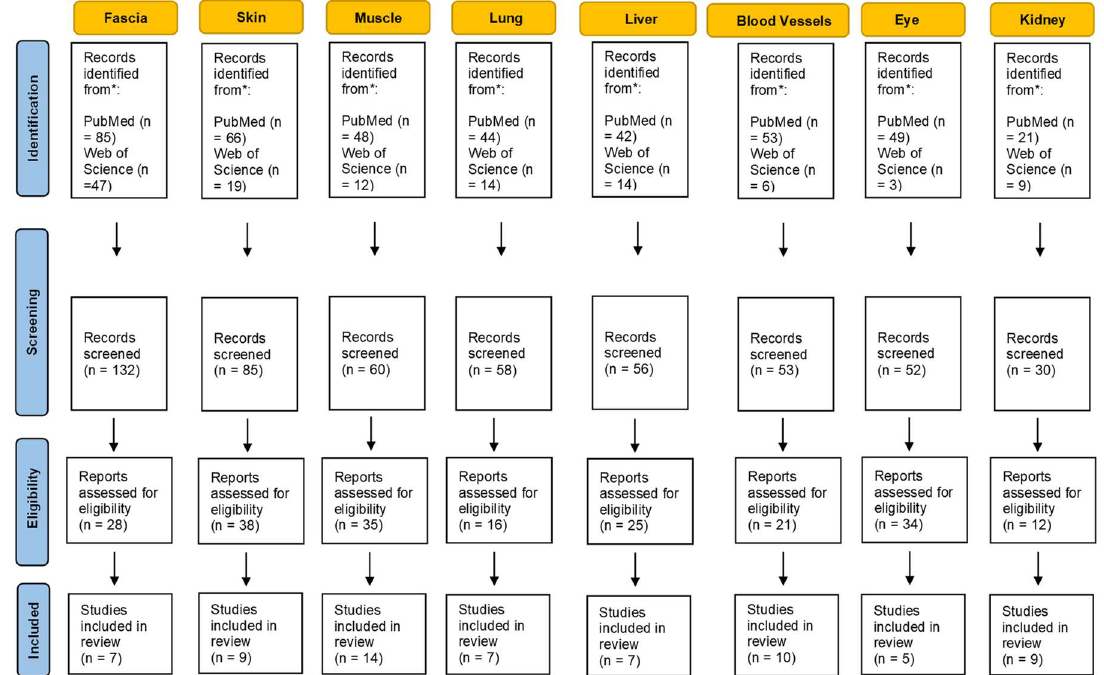
Figure 1. Flowchart of selection process and identification of eligible studies.